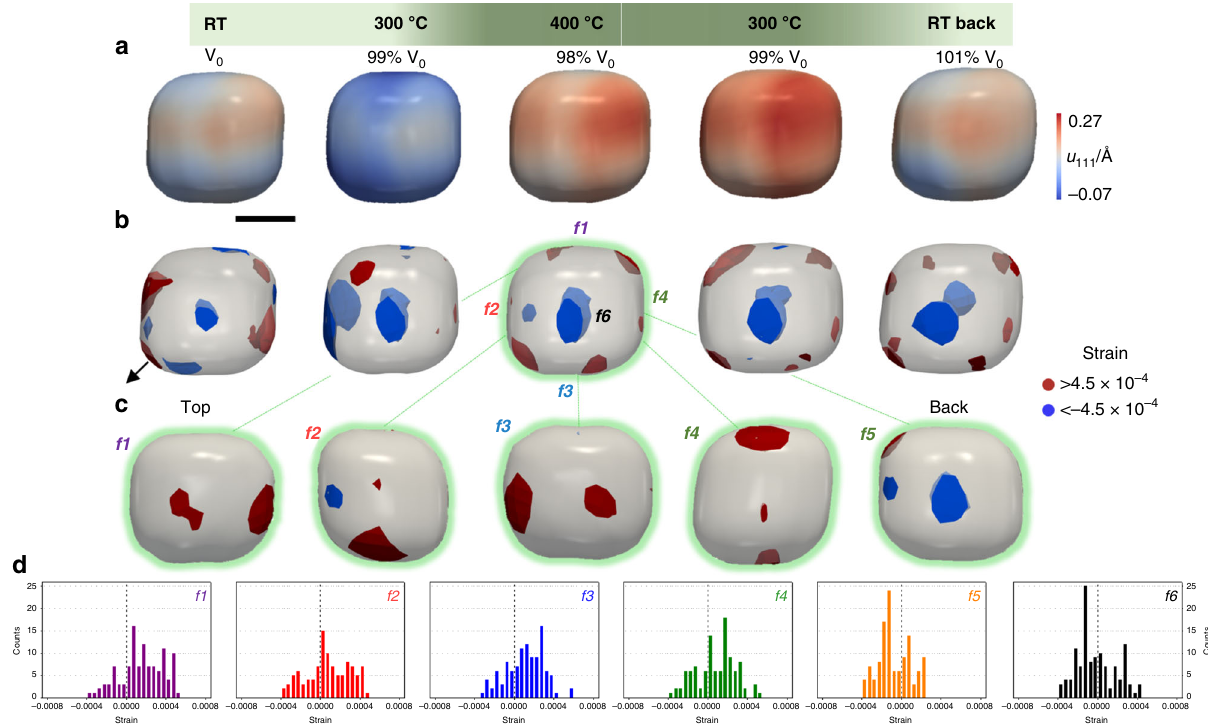
Fig. 5 Operando 3D distribution of the displacement fi eld during CO oxidation reaction. a Displacement fi eld along (111) of the same AuNP2 nanoparticle under CO/O 2 at RT, 300 and 400 °C, during the entire catalytic hysteresis loop. b Corresponding 3D strain structure of highly compressive (blue, strain < − 0.00045) and tensile (red, strain > 0.00045) strained regions. The black arrow is indicating the orientation of the q 111 scattering vector. The particle shape is shown as a semi-transparent grey isosurface. c 3D strain distribution at 400 °C with maximum of compressive (blue) and tensile (red) strains regions of the six {100} facets of the cube ( f1 to f6 ). d Statistical distribution of strain of the cube facets ( f1 violet, f2 red, f3 blue, f4 green, f5 orange and f6 black). Scale bar, 30 nm. The green gradient is illustrating the increase/decrease of catalytic